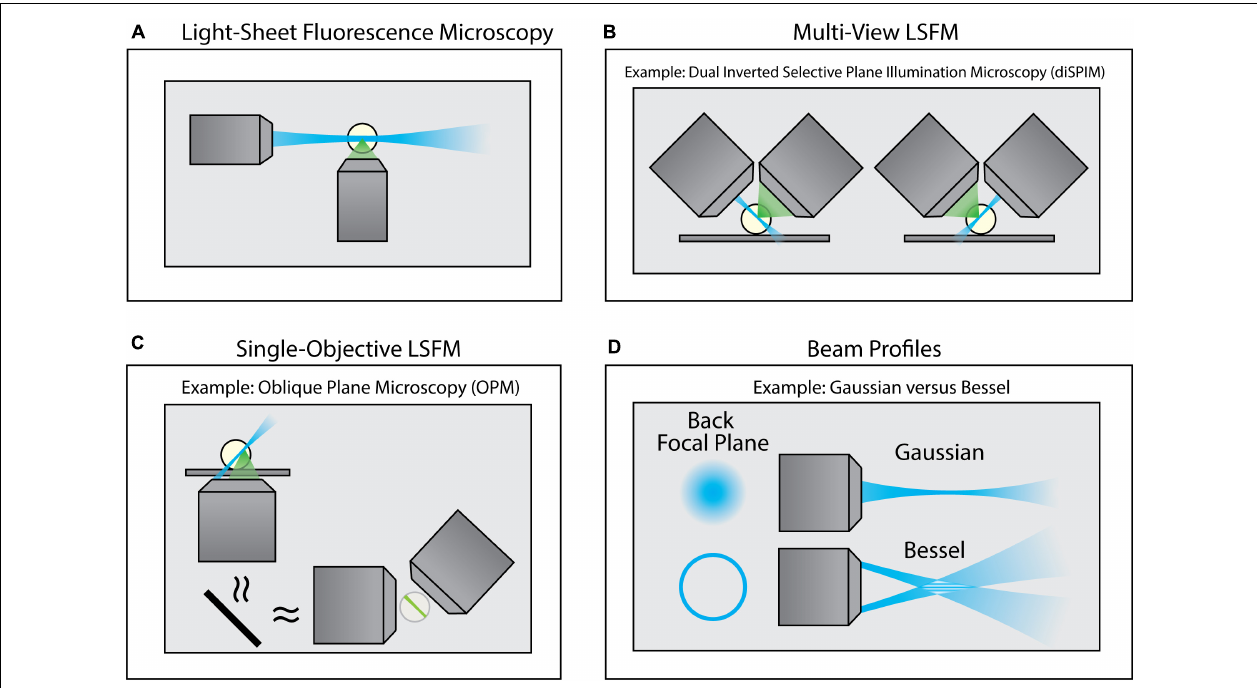
FIGURE 4 | Variants of Light-Sheet Fluorescence Microscopy (LSFM). (A) Using an illumination objective lens, conventional LSFM illuminates a thin section of the sample that is coplanar with a separate detection lens. This restricts excitation to only the portion of the sample being imaged, thus improving contrast and minimizing photodamage. (B) Multi-view LSFM (e.g., diSPIM) can achieve multiple viewing angles by alternating the function of both objective lenses (as shown) or by incorporating multiple detection objective lenses to image the sample. Computational fusion of these multiple viewing angles can enable isotropic resolution, as